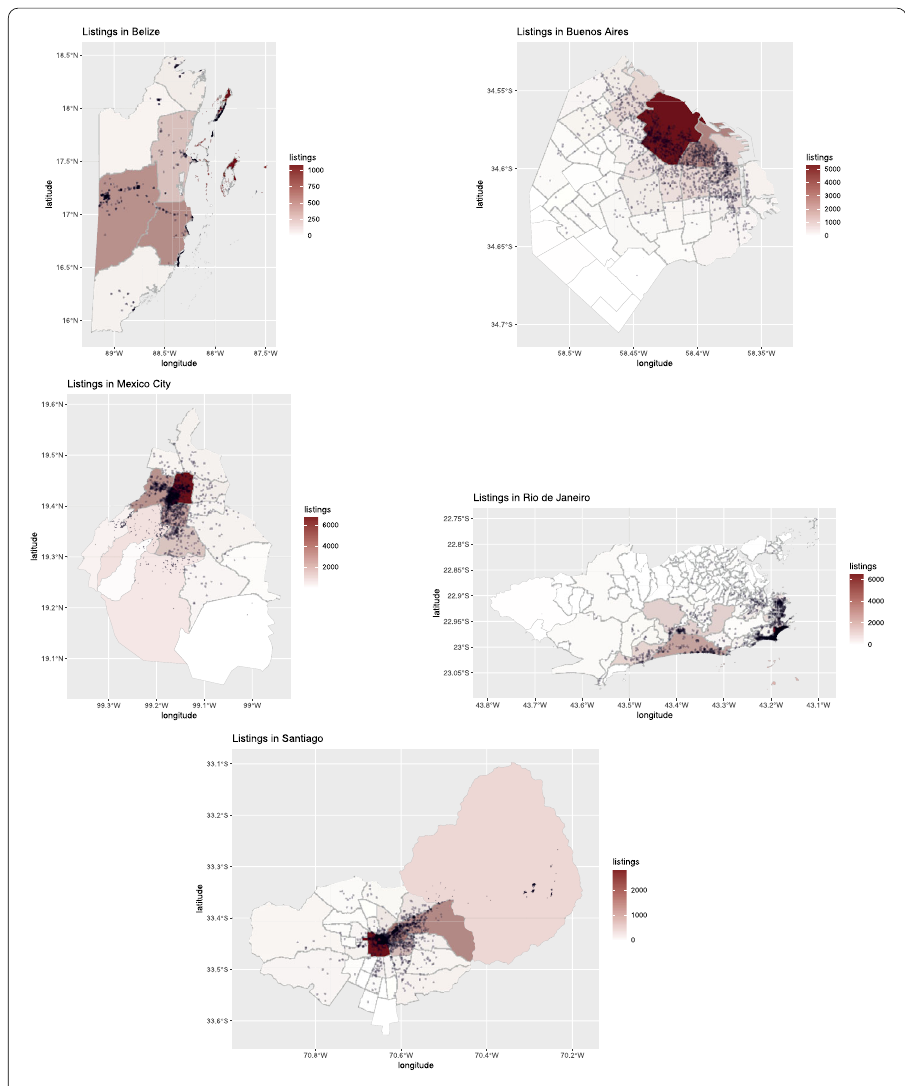
Figure 15 Offer (host) density in the five Latin American cities